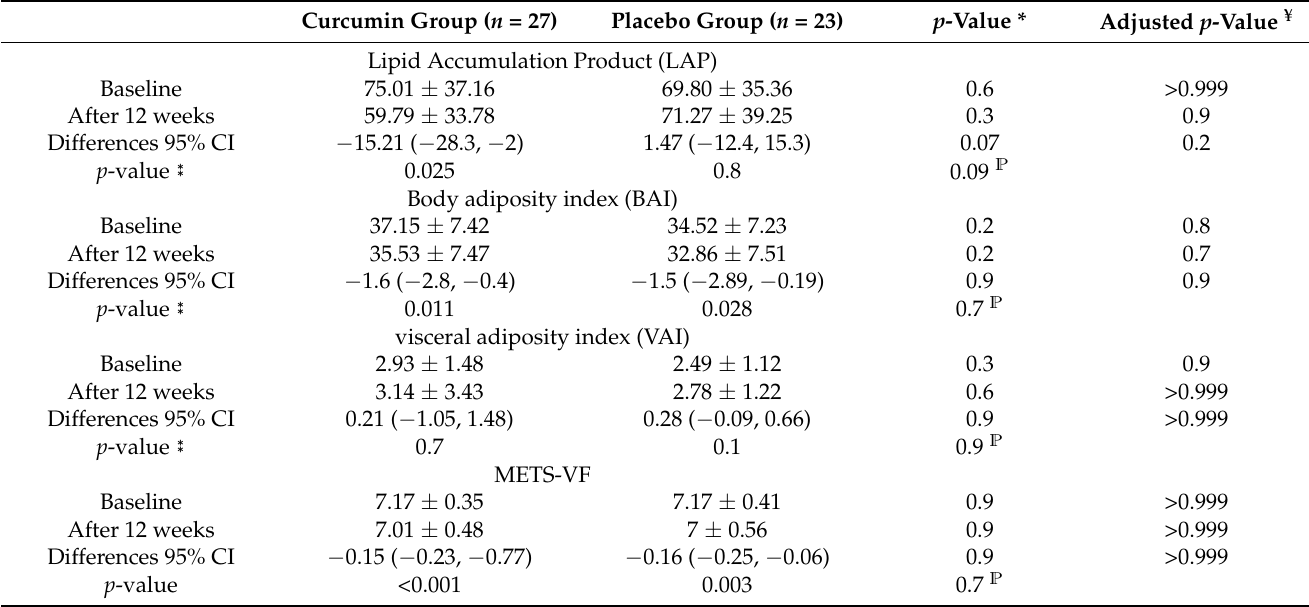
Table 3. Adipose tissue-related indices before and after the study. Table 2. Comparison of atherogenic indicators before and after of the trial. Table 2. Comparison of atherogenic indicators before and after of the trial.